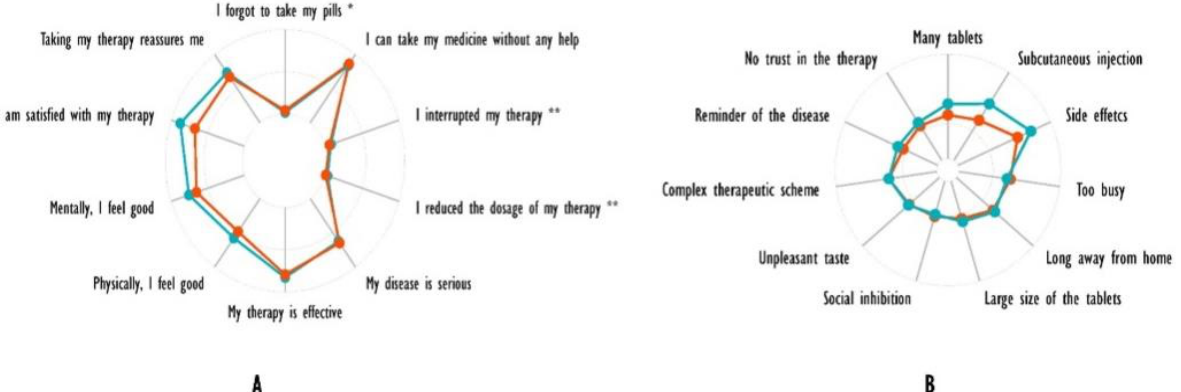
Figure 2. ( A ) Graphical representation of the patients’ reported treatment adherence. ( B ) Graphical representation of the main reason that led patients to discontinue the therapy. * in the last week; ** in the last 4 weeks. Red —Baseline; Blue —After 6 months.